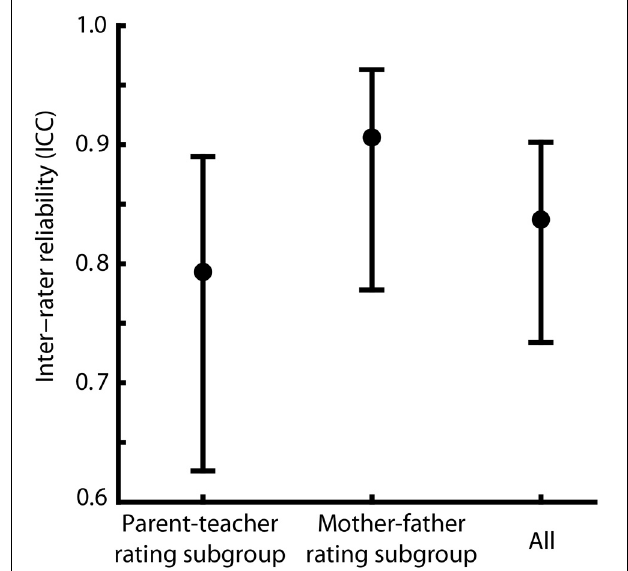
FIGURE 2 | Comparison of inter-rater reliability. Intra-class correlation coefficients (ICCs, represented as dots) and corresponding confidence intervals at α = 0 . 05 (CIs, represented as error bars) for parent–teacher ratings, mother–father ratings and for all rating pairs across rater subgroups. Overlapping CIs indicate that the ICCs did not differ systematically from each